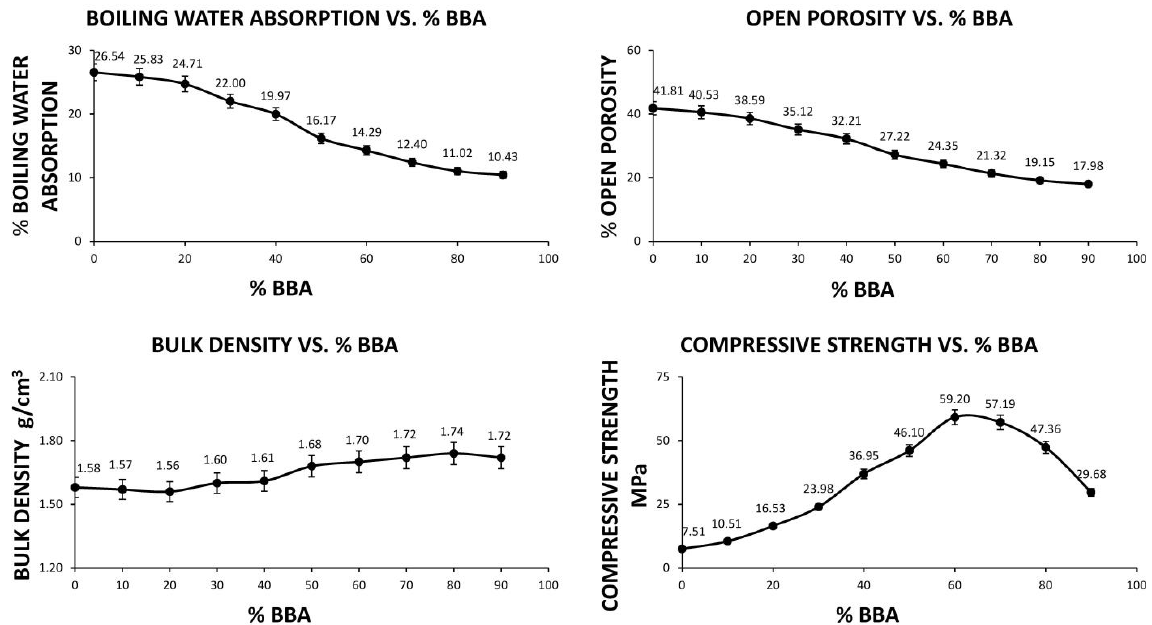
Figure 4. Graphs of boiling water absorption, open porosity, bulk density and compressive strength of the different samples groups of geopolymers.